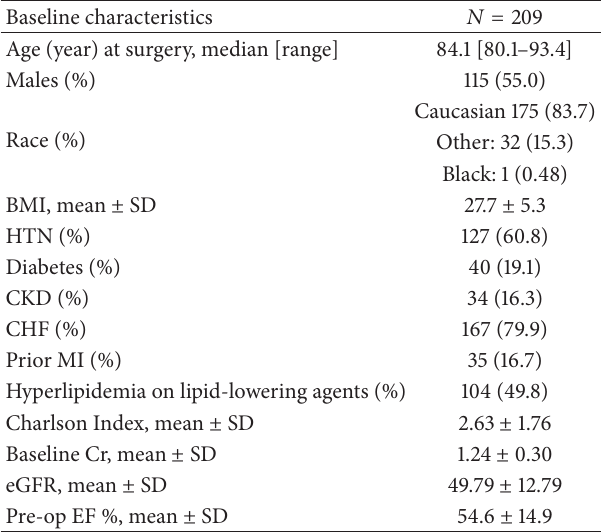
Table 1: Preoperative characteristics of